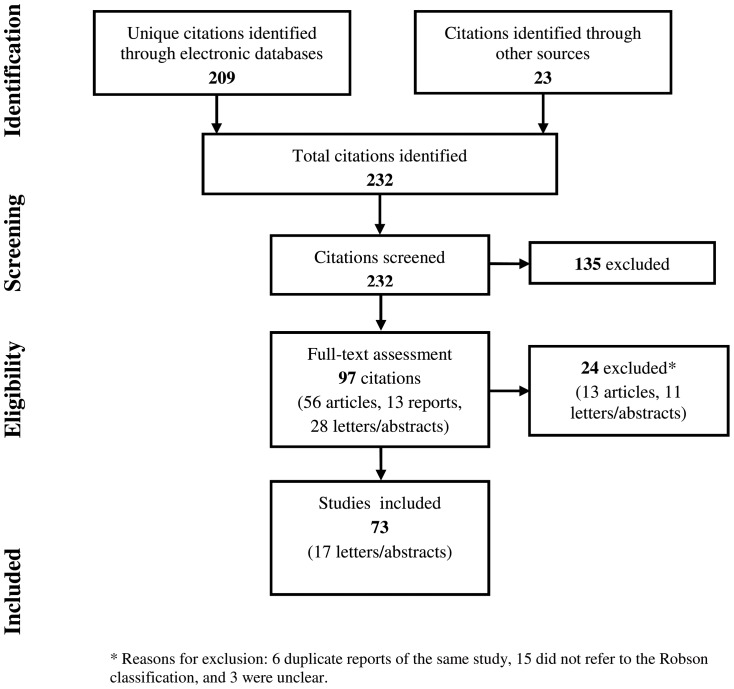
Flowchart of the systematic review.